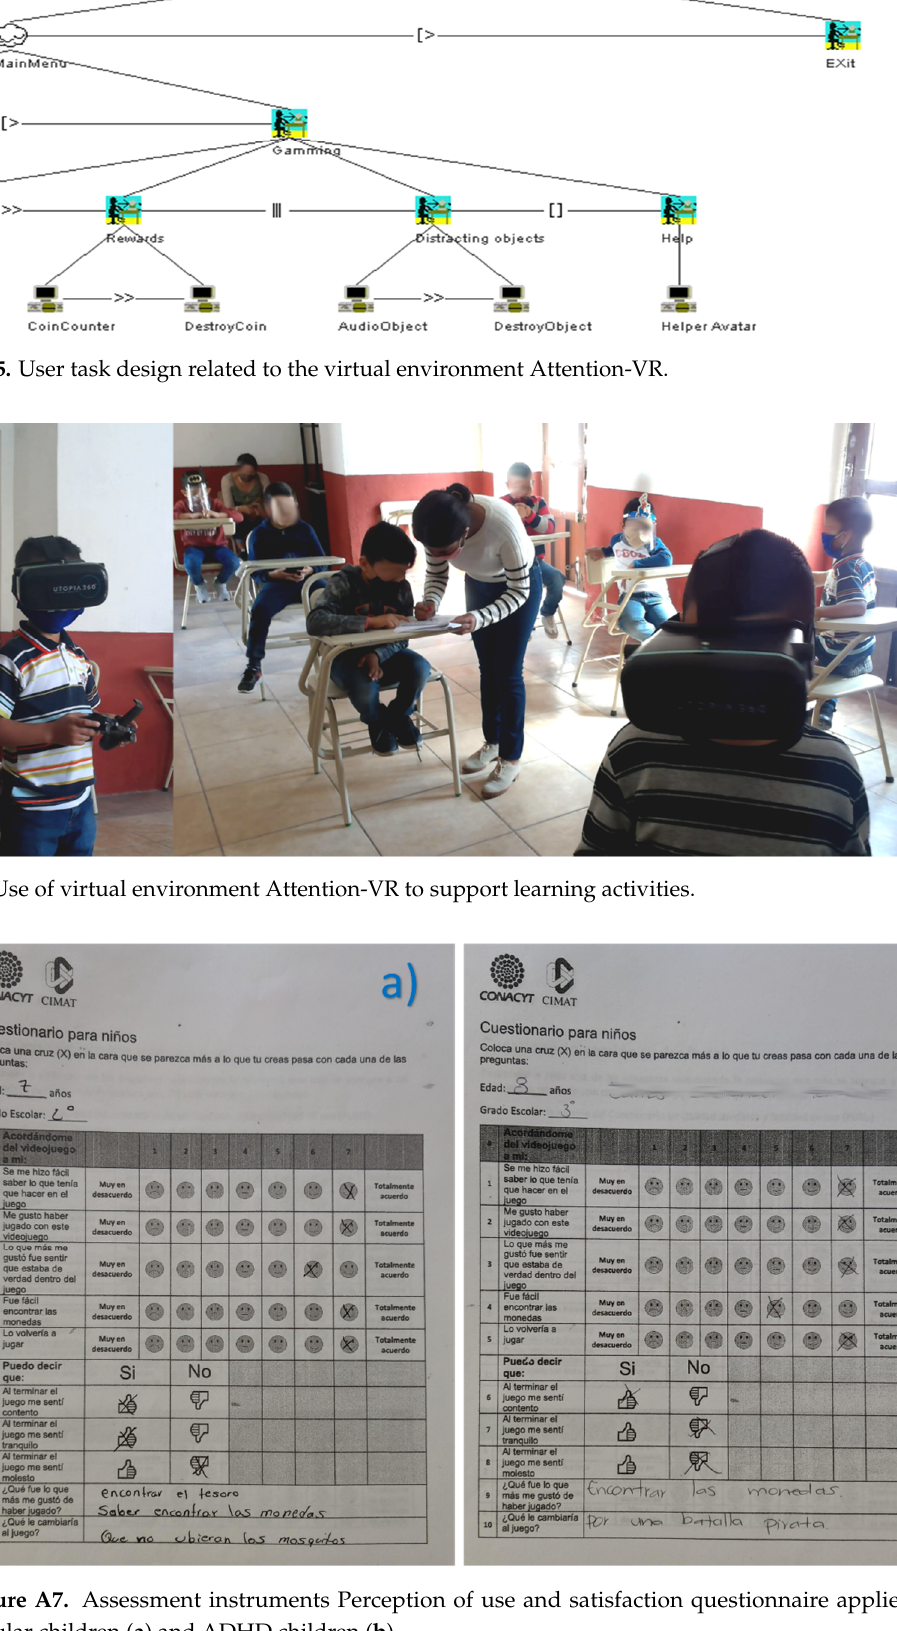
Figure A8. Map of the interactive environment Attention-VR.